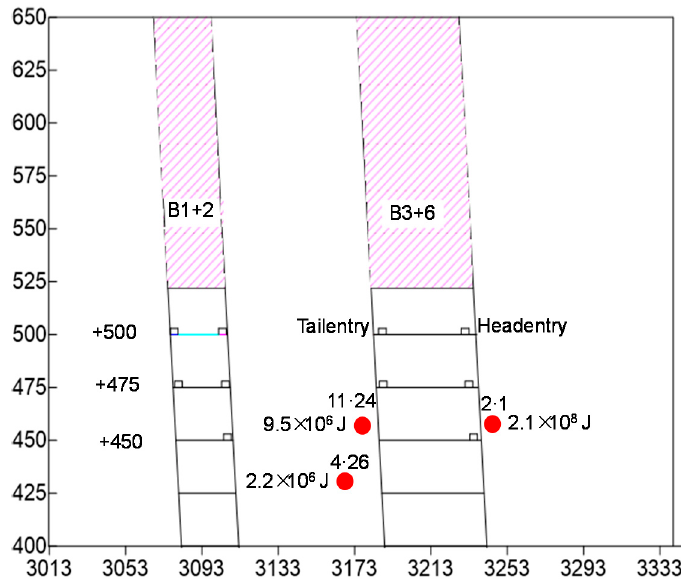
Figure 13. Elevation of each rockburst source spatial distribution.